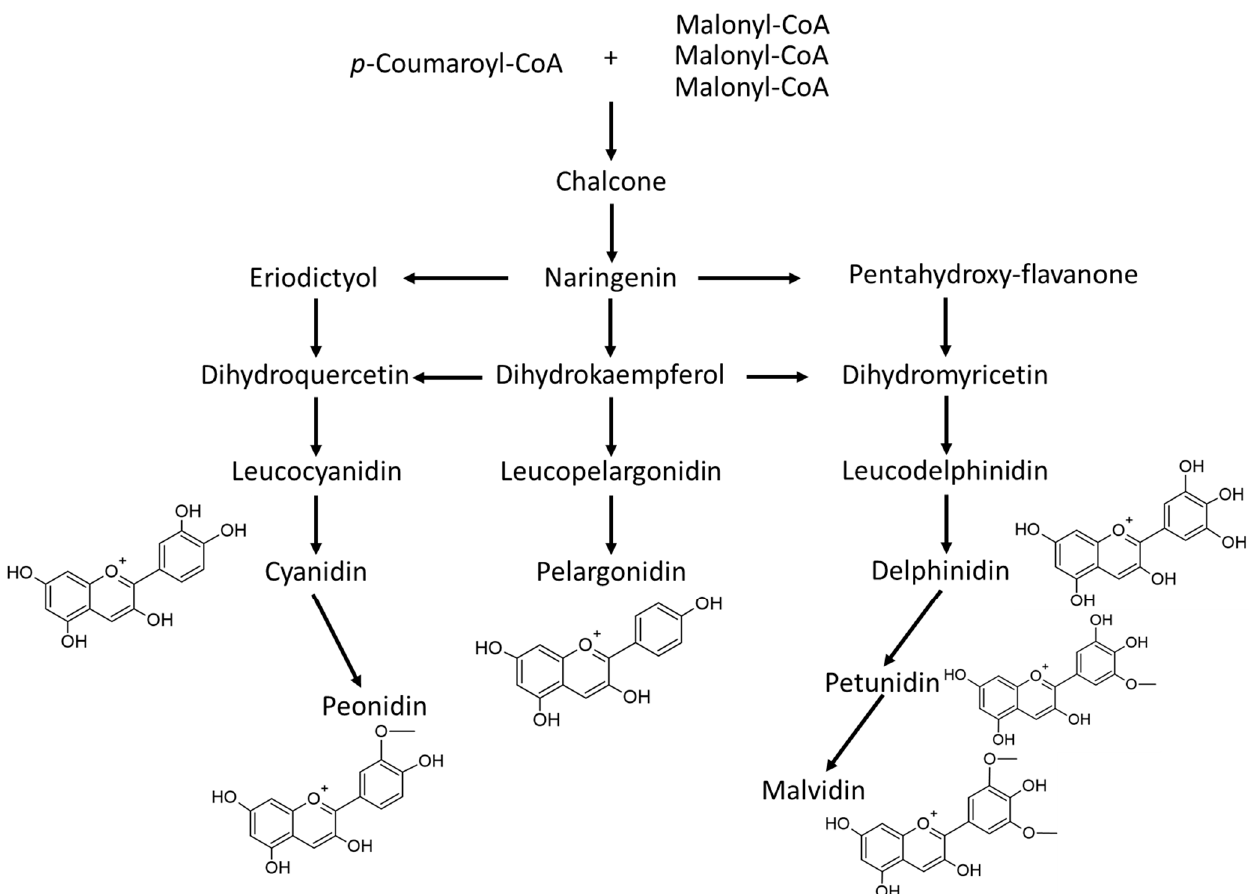
Figure 1. Biosynthesis of six important anthocyanidins [11].